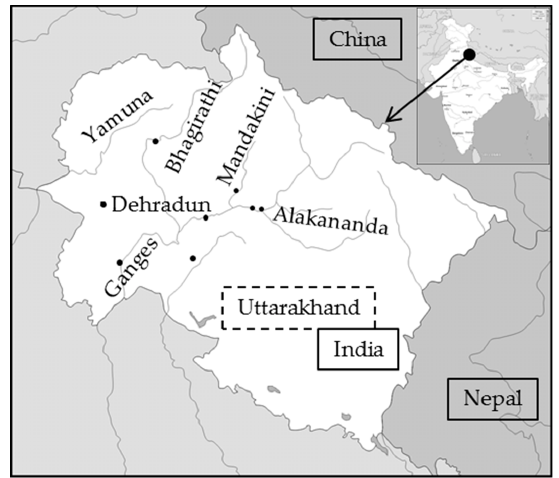
Figure 2. Map with sampling locations in Uttarakhand, India.